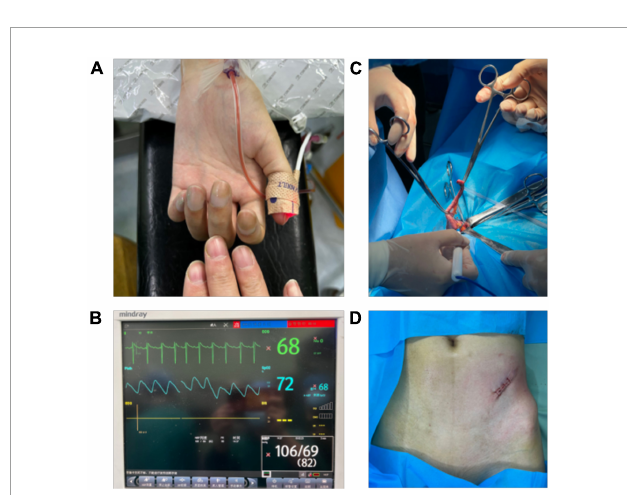
FIGURE3 Images of patients during surgery. (A) Compared with the fingers of normal people, the finger color of the patient was purple. (B) Patient’s heart rate, blood pressure, and pulse oxygen saturation. (C) The moment when the patient’s appendix was removed. (D)